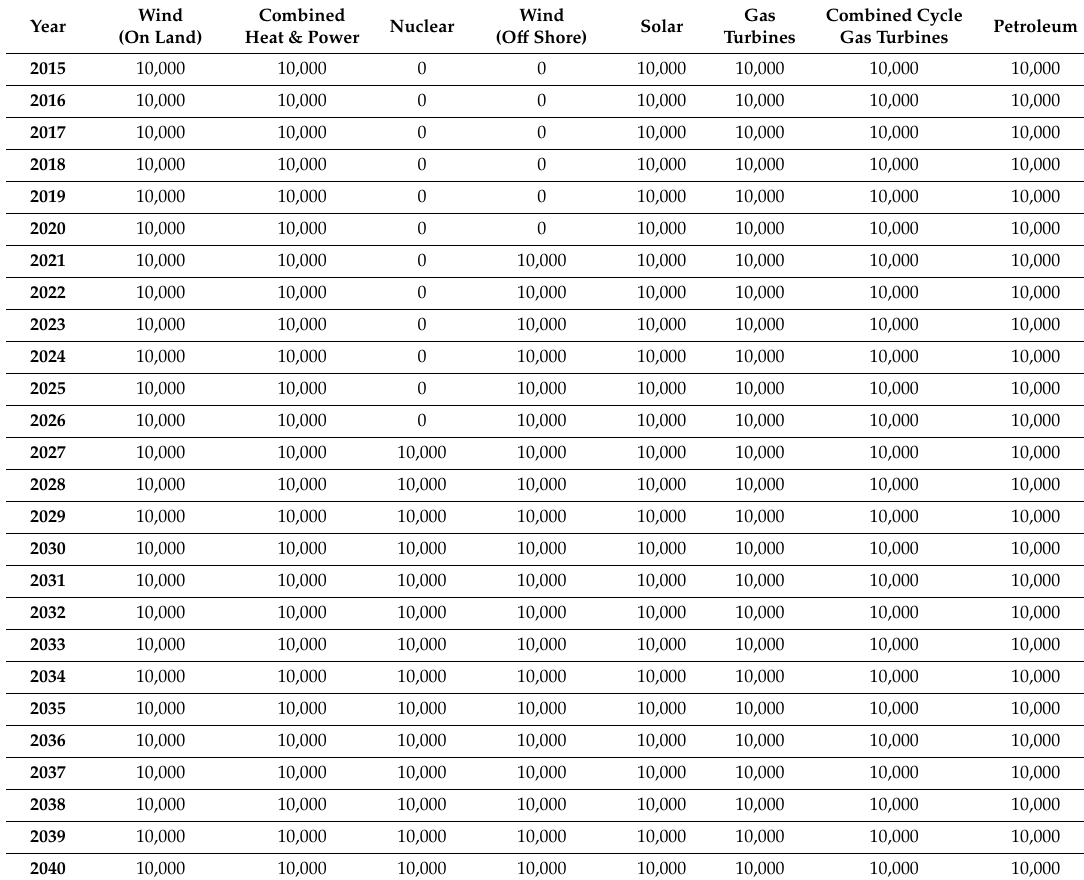
Table A14. Annual Construction Limits by Unit (in MW per Region).